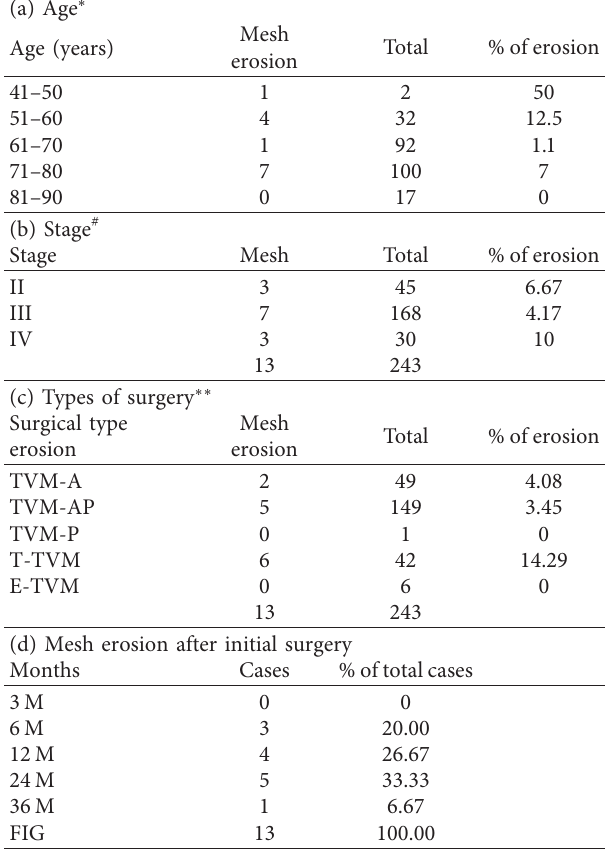
Table 2: Cases of recurrence after TVM surgery. Table 3: Cases of mesh erosion after TVM